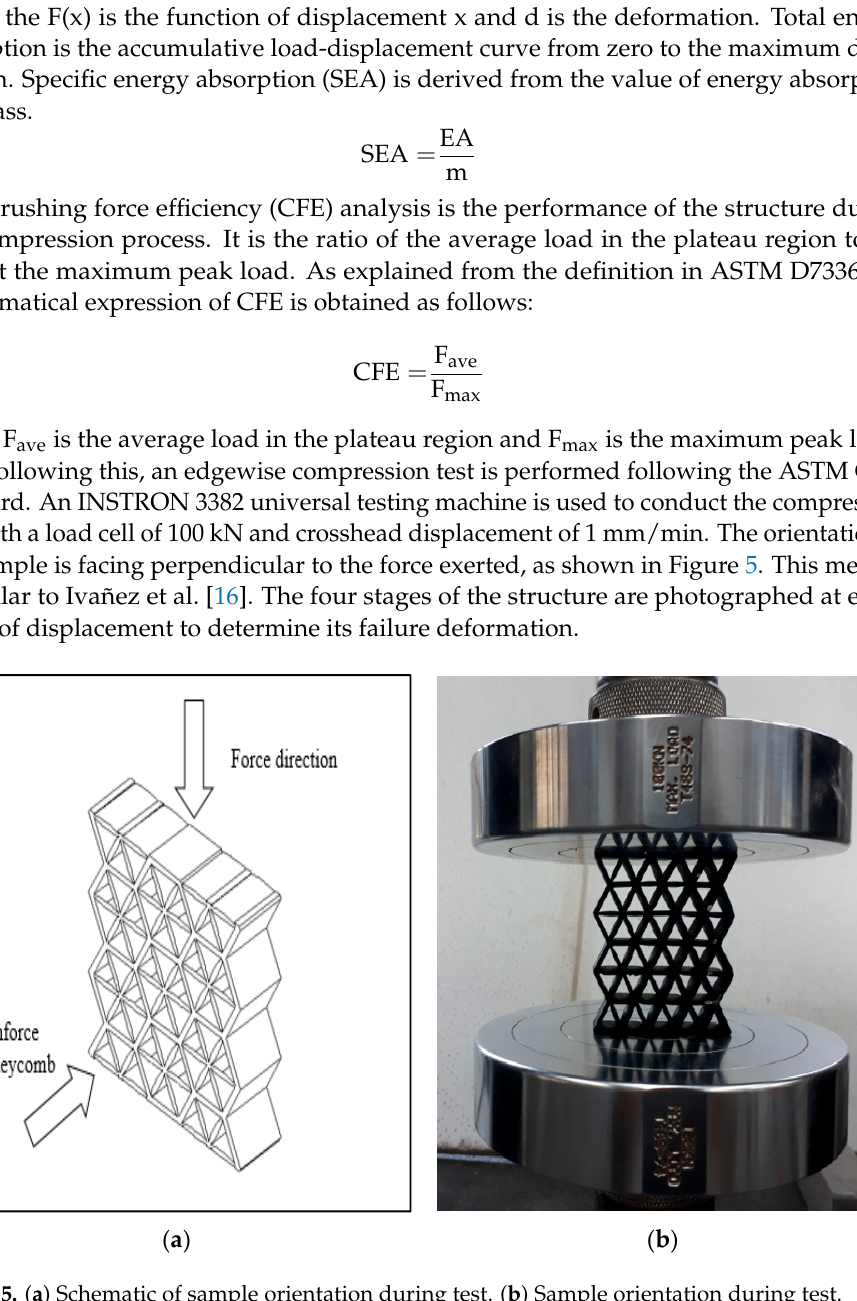
Figure 5. ( a ) Schematic of sample orientation during test. ( b ) Sample orientation during